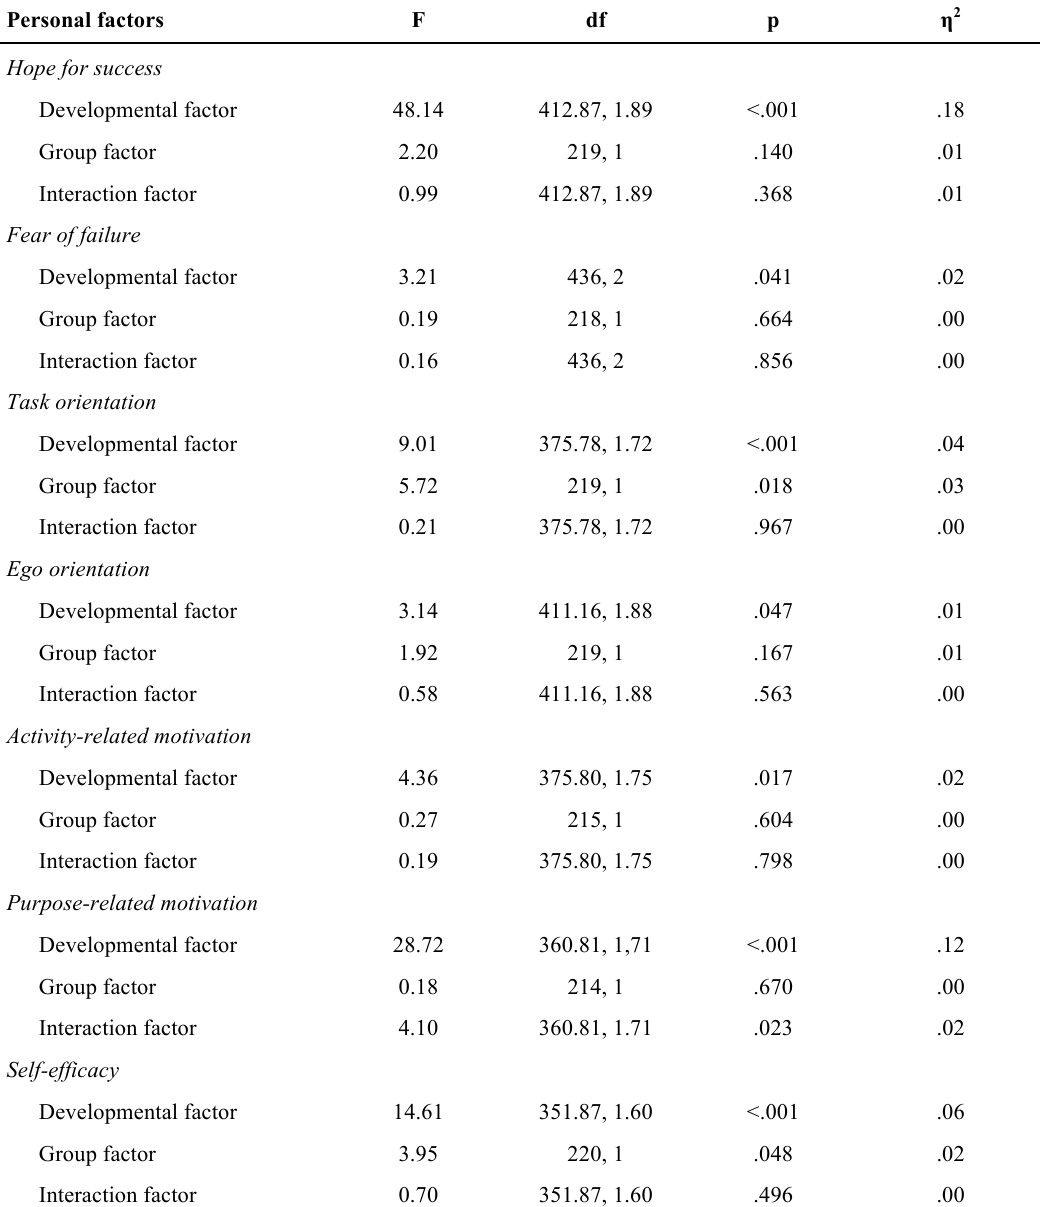
Table 4. Development of personal factors during elite sports careers (Repeated Measures ANOVAs controlled for gender and